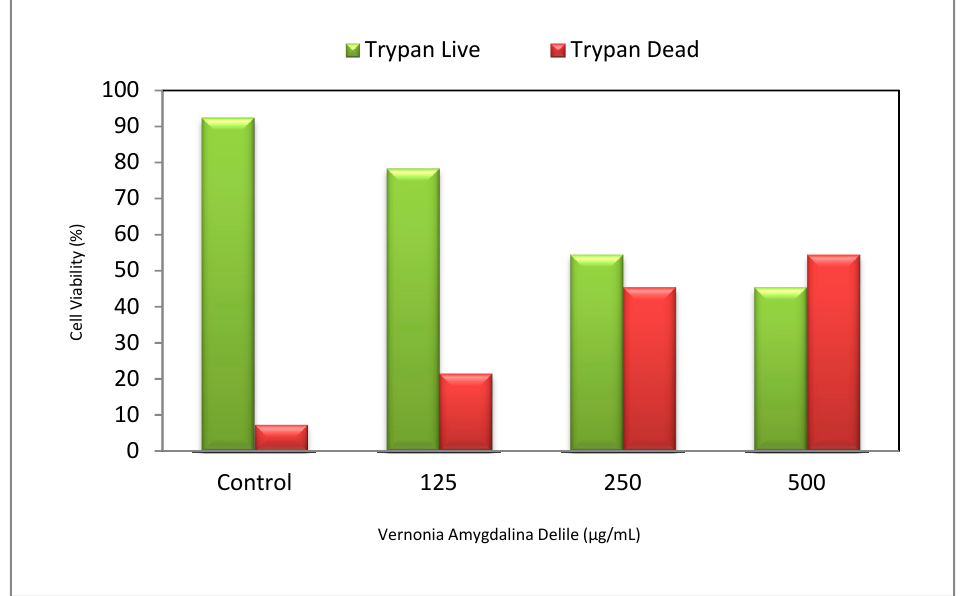
Figure 1. Antiproliferative effect of Vernonia amygdalina Delile (VAD) on PC-3 cells. Growth inhibition of PC-3 cells treated with different doses of VAD for 48 h and measured by trypan blue test. Data are means ± SD from three independent determinations in triplicate.